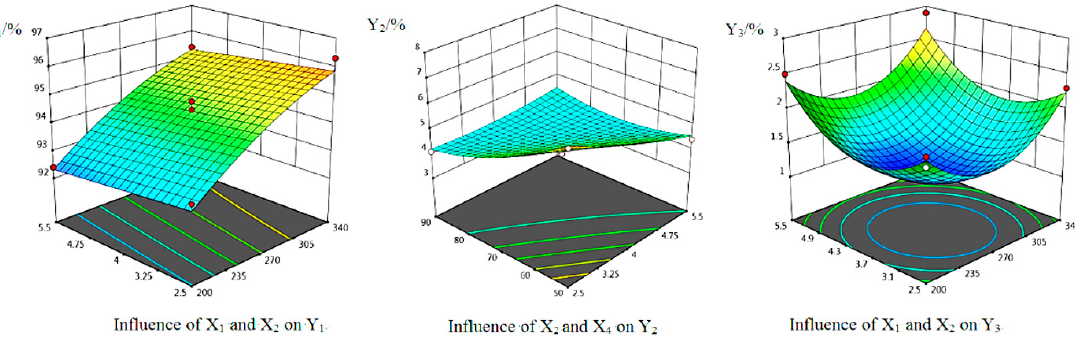
Figure 7. Interactions between factors on the operating indexes. The colors in the figure show the the changing trend of data, the most dark color mean the data changes most obviously.